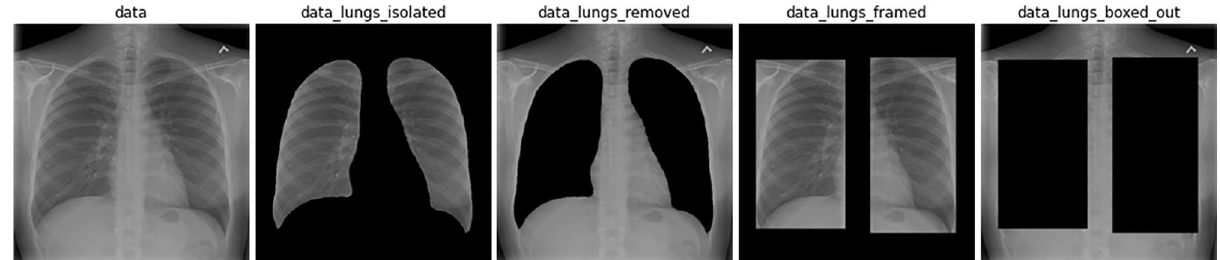
Figure 1. From raw chest X-ray to modified image version for testing deep learning inference: proposed representations to inspect lung classification accuracy in the ROI Hide-and-Seek